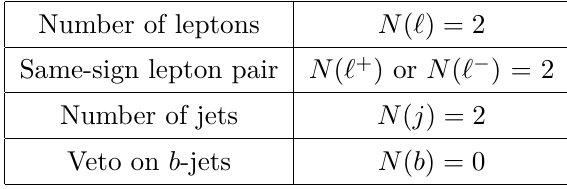
Table 2 . The requirements for the final state topology. Here ‘ = e, µ